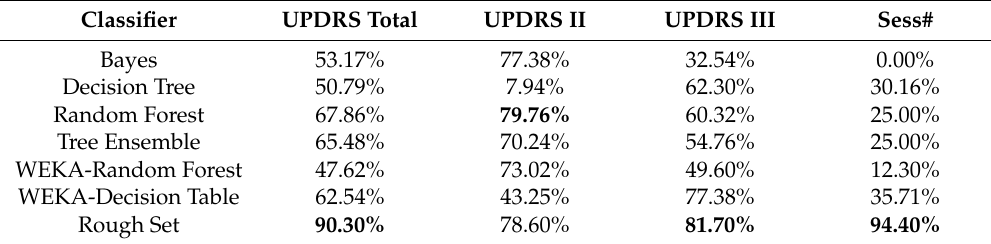
similar level, with the exception of classifiers for the session. Classifiers were tested on dataset with PDQ